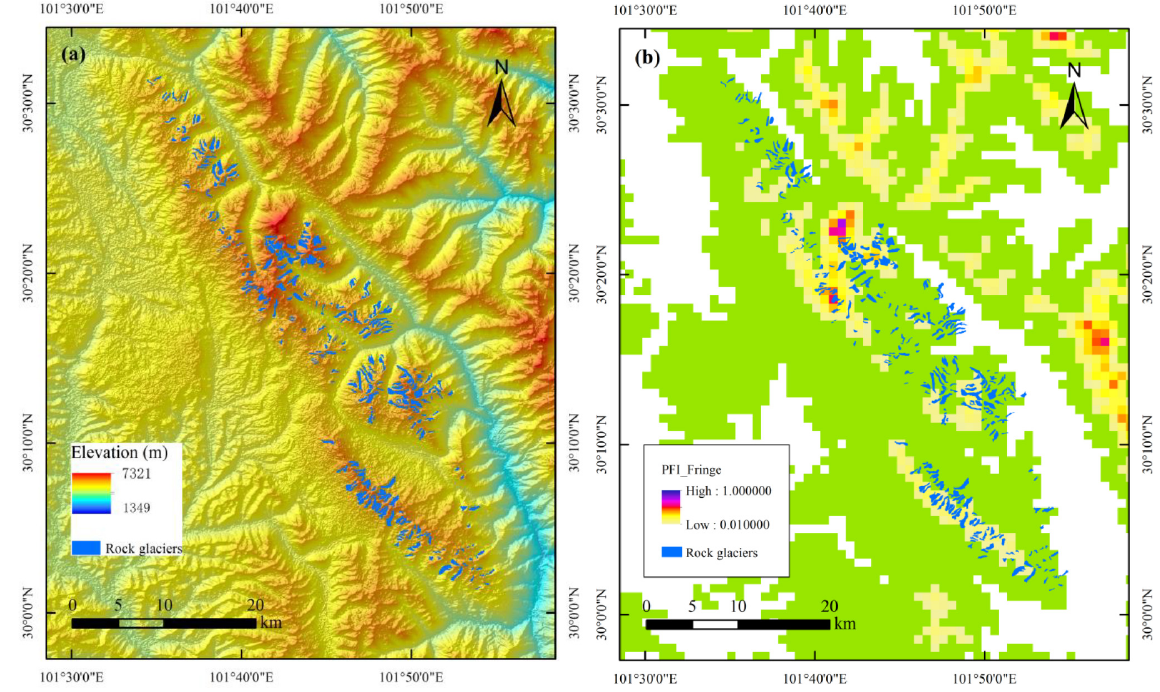
Figure 3. Spatial distribution of rock glaciers vs. (a) elevation (ASTER GDEM V2) and (b) Gruber’s (2012) Permafrost Zonation Index (PZI) in Daxue Shan. The green area represents the fringe of uncertainty.